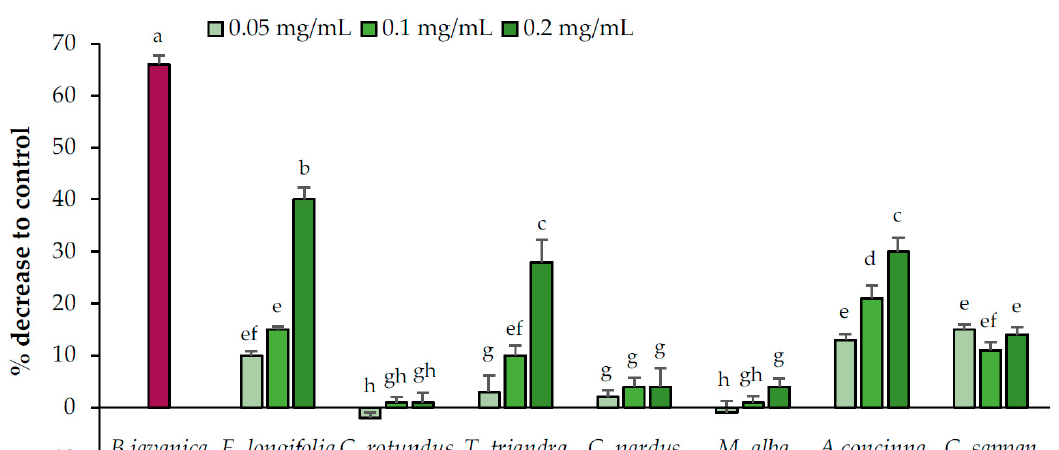
Figure 4. Lipid accumulation reduction activities of the candidate plant extracts. Brucea javanica (positive control) was used at 0.05 mg/mL. Data are expressed as means ± standard deviation. Means with different letters are significantly different (Tukey’s test, p < 0.05).